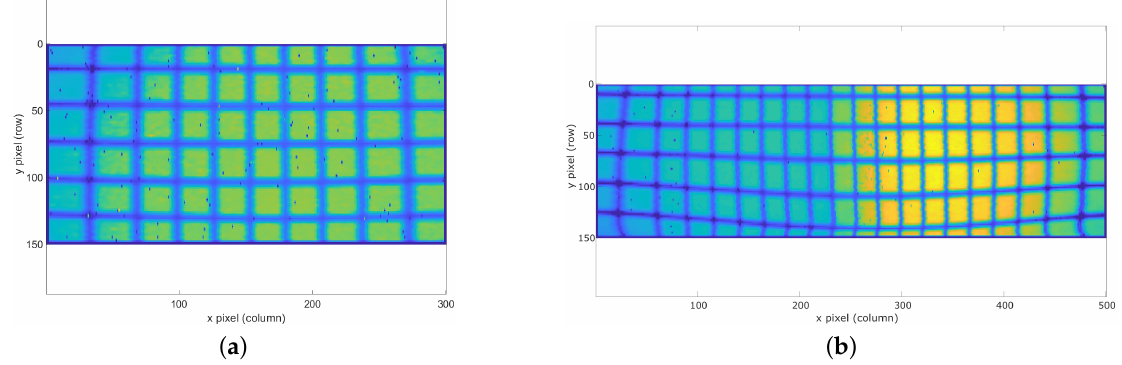
Figure 6. Acquired images of the calibration pattern with the ( a ) 30 × 20 ◦ FOV and ( b ) 50 × 20 ◦ FOV LiDAR